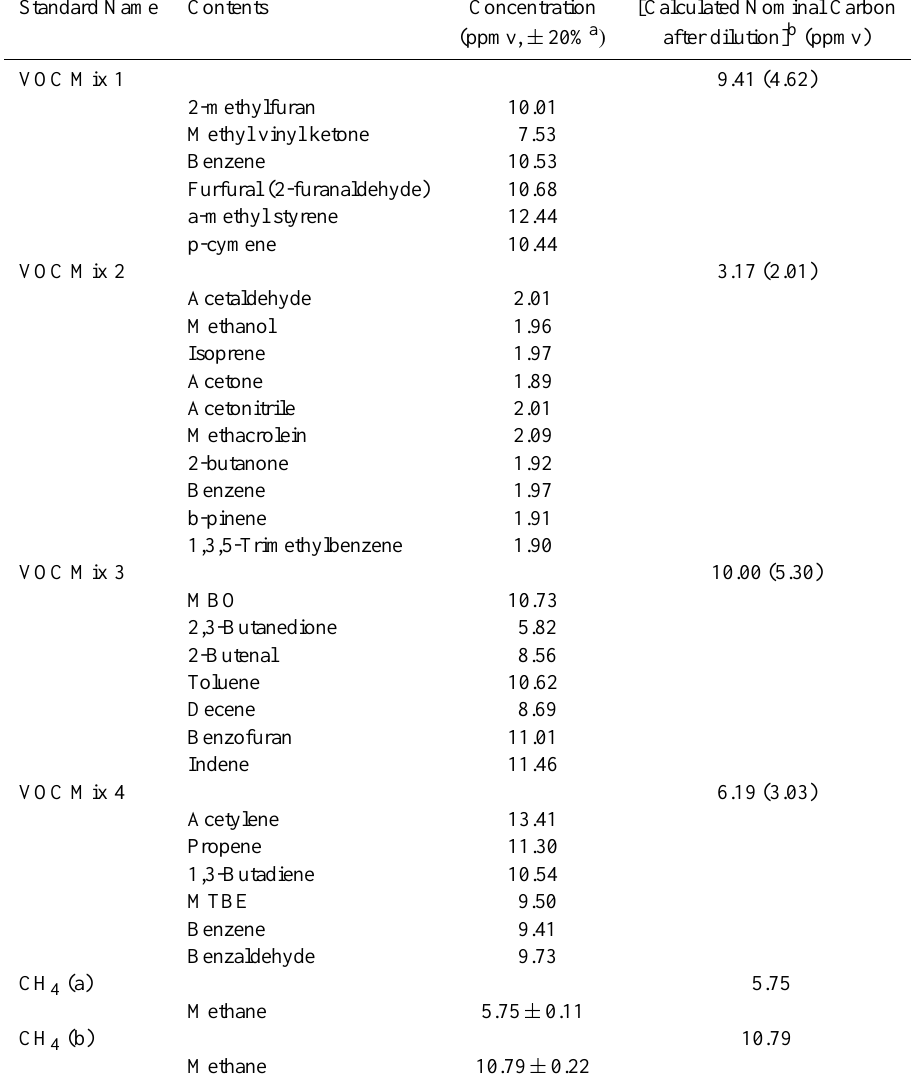
Table 1. Standard gas